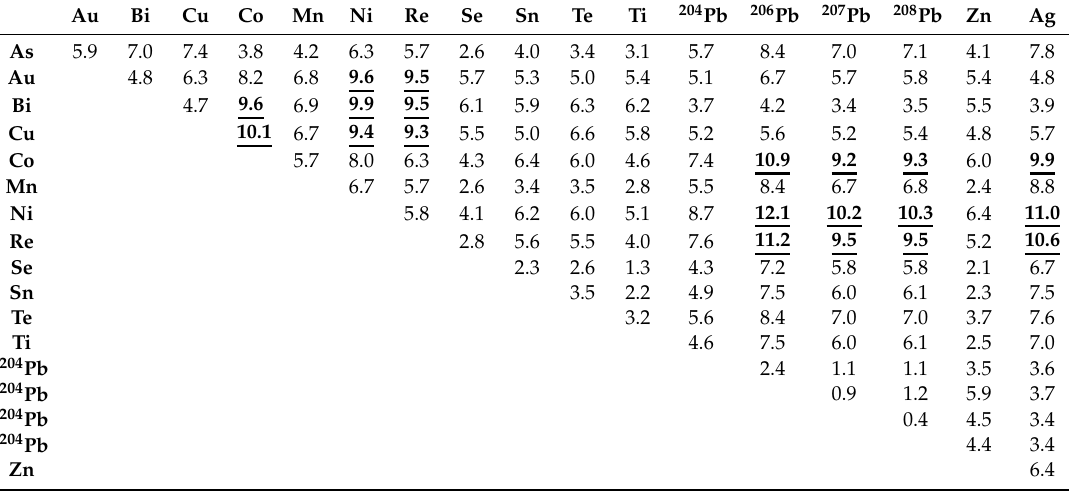
Table 4. Variation matrix for the N = 525 dataset with entries as the variances of log-ratios for each element pair. The underscored values indicate the weakest column-wise